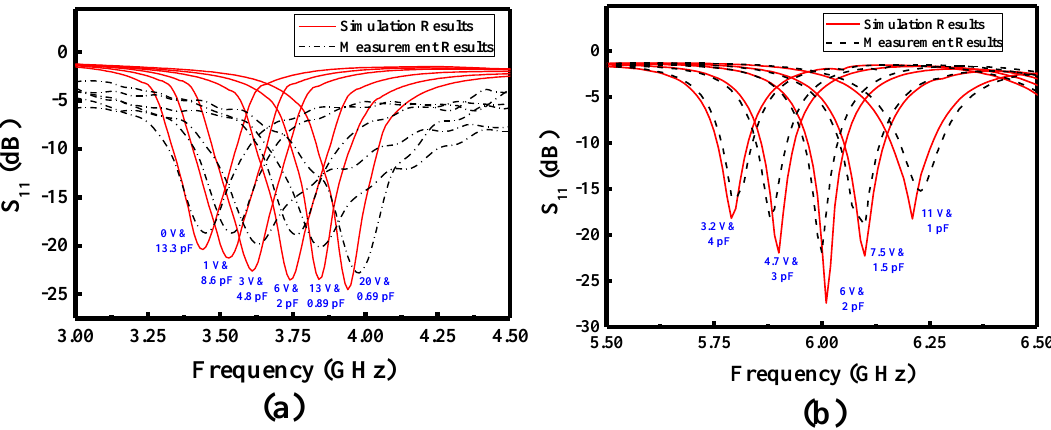
Figure 5. ( a ). Simulated and measured return losses for the antenna (four smaller side patches are all connected to the larger main patch). ( b ). Simulated and measured return losses (one smaller side patch is connected to the larger main patch).